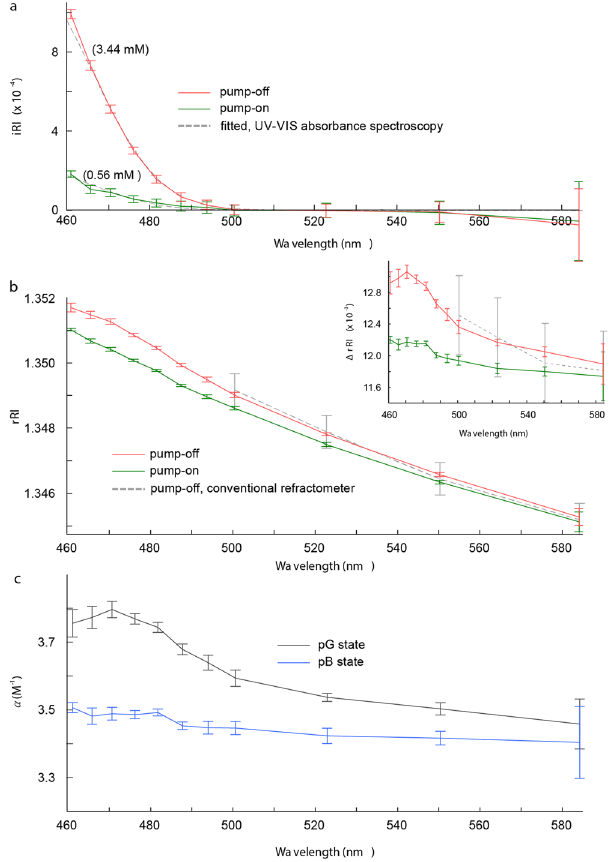
Figure 2. Measured CRI and refractive index increment of PYP solution. ( a ) The red line represents the i RI value of the PYP solution in the absence of pump beam illumination (pump-off). The green line represents the i RI value of the PYP solution in the presence of pump beam illumination (pump-on). The grey dotted line represents the fitted graphs of both of these values, based on Eq. (2). Corresponding concentrations of the ground state PYP are indicated in brackets on each line. ( b ) The r RI values of the PYP solution in the pump- off (red) and pump-on (green) environments. The grey dotted line represents the r RI result for a pump-off PYP solution obtained from a conventional refractometer for comparison. The inset shows the result after subtracting the r RI of distilled water from the PYP solution. ( c ) Refractive index increment ( α ) of pG (black) and pB (blue) states. The error bars indicate the standard deviation from five measurements with different microspheres immersed in identical PYP